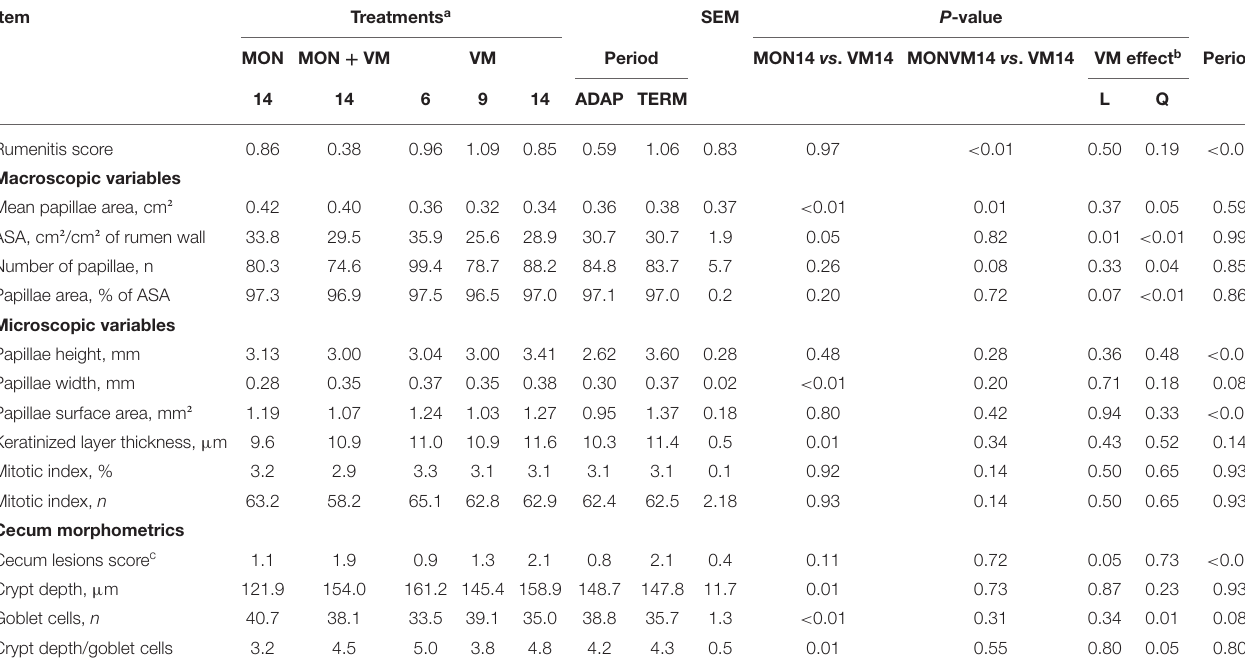
TABLE 6 | Rumen and cecum morphometrics of Nellore yearling bulls consuming high-concentrate diets containing sodium monensin (MON), virginiamycin (VM), or both during the adaptation and finishing periods.